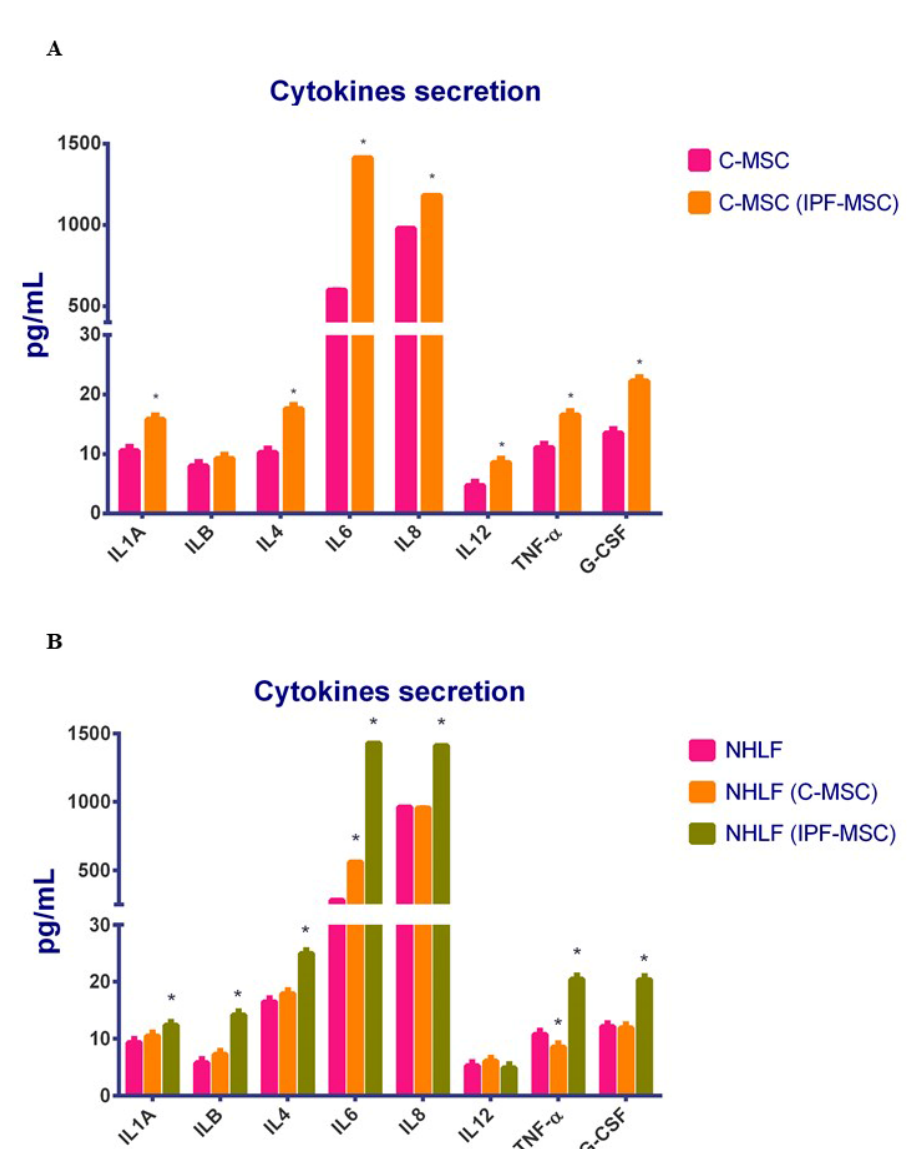
Figure 8. Cytokines secretion after co-cultures. The secretion of IL1A, IL1B, IL4, IL6, IL8, IL12, TNF- α, and G-CSF was evaluated by ELISA after co-culture between C- and IPF-MSC ( A ) and among NHLF and MSCs ( B ). Levels of secretion were measured on collected medium after 72 h of co-culture and are referred to as pg/mL. Data are means ± SD from analyses performed on three separate experiments in triplicates. In figure ( A ) the * indicates significative differences between C-MSCs and C-MSC(IPF-MSC); in figure ( B ) the * indicates significative differences between NHLF and NHLF(C-MSC) and between NHLF and NHLF(IPF.MSC); (one-way ANOVA; p < 0.05). C-MSCs: mesenchymal stem cells (MSCs) from controls cultured alone; C-MSC (IPF-MSCs): C-MSCs after 72 h of co-culture with IPF; NHLF: NHLF cultured alone; NHLF (C-MSCs): NHLF co-cultured with C-MSCs for 72 h; NHLF (IPF-MSCs): NHLF co-cultured with IPF-MSCs for 72 h